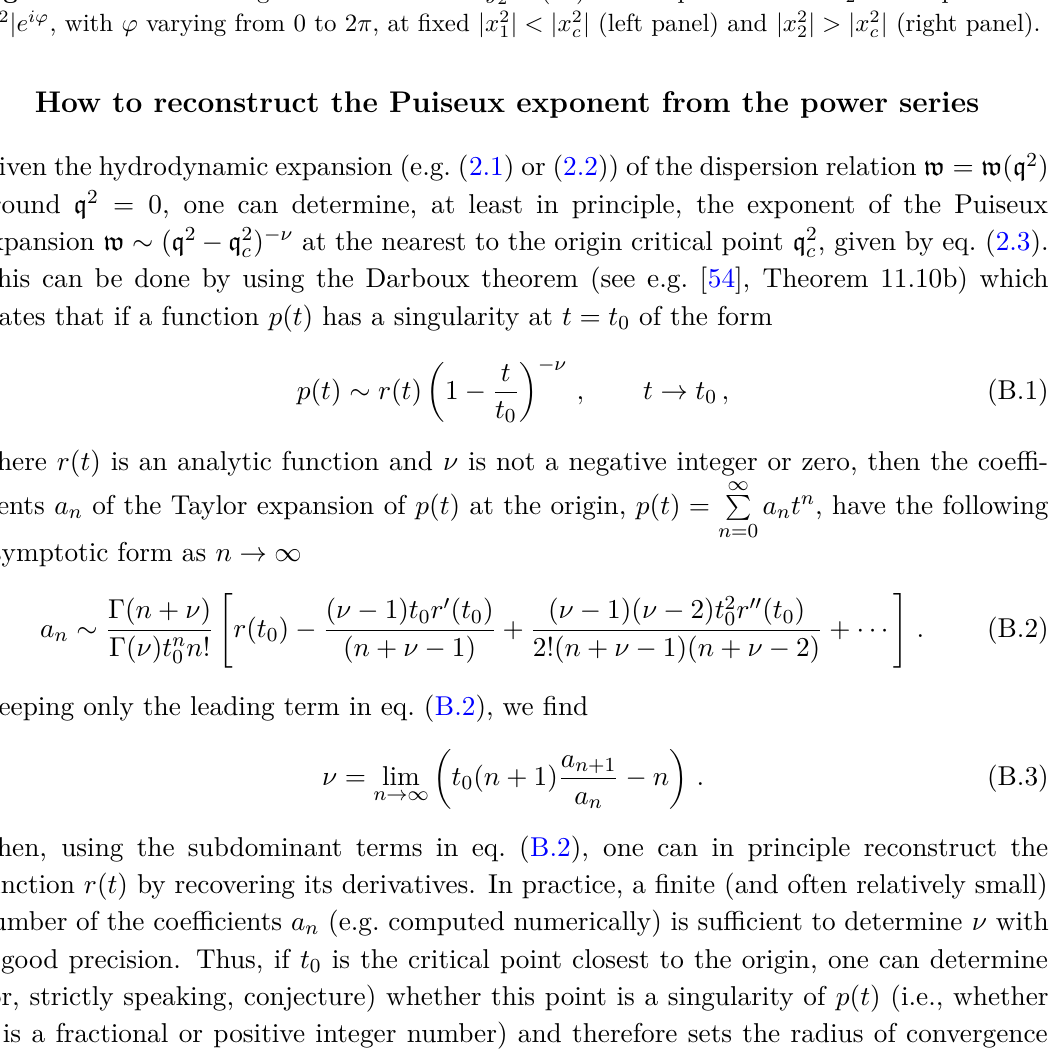
Figure 23 . Level-crossing: the two branches y (1 , 2) | x 2 | e iϕ , with ϕ varying from 0 to 2 π , at fixed | x 2